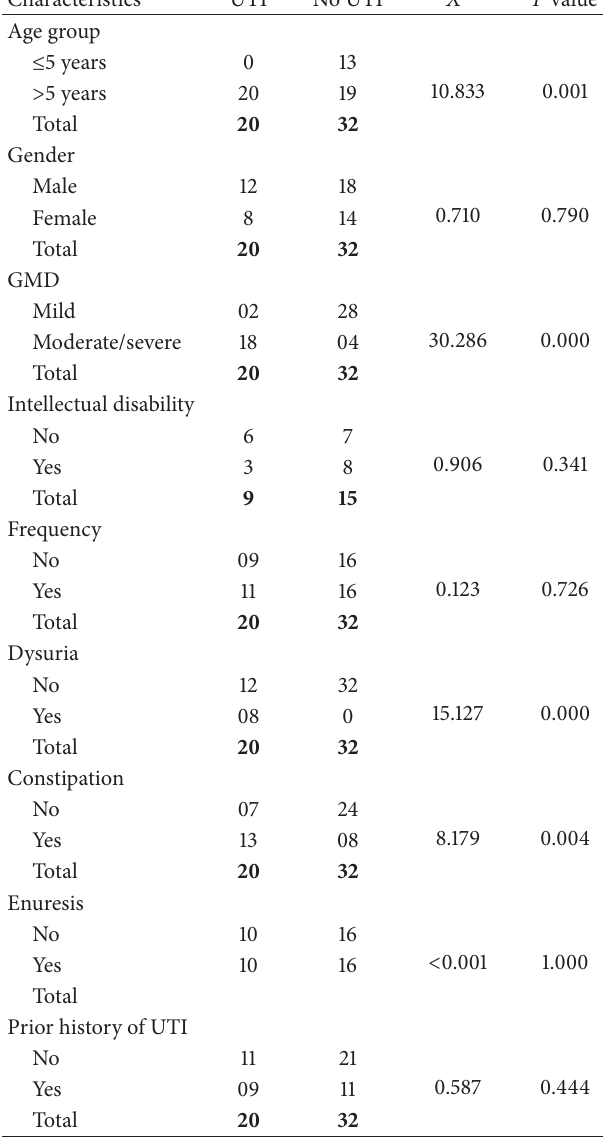
Table 4: Association between some characteristics of subjects with CP and presence of UTI.